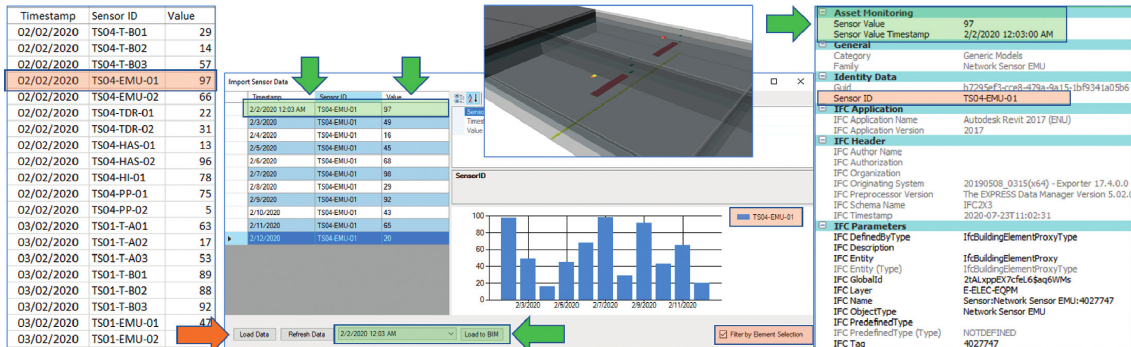
Figure 7: Sensor Data Integration Data Flow Scheme, import of test sensor data by metadata